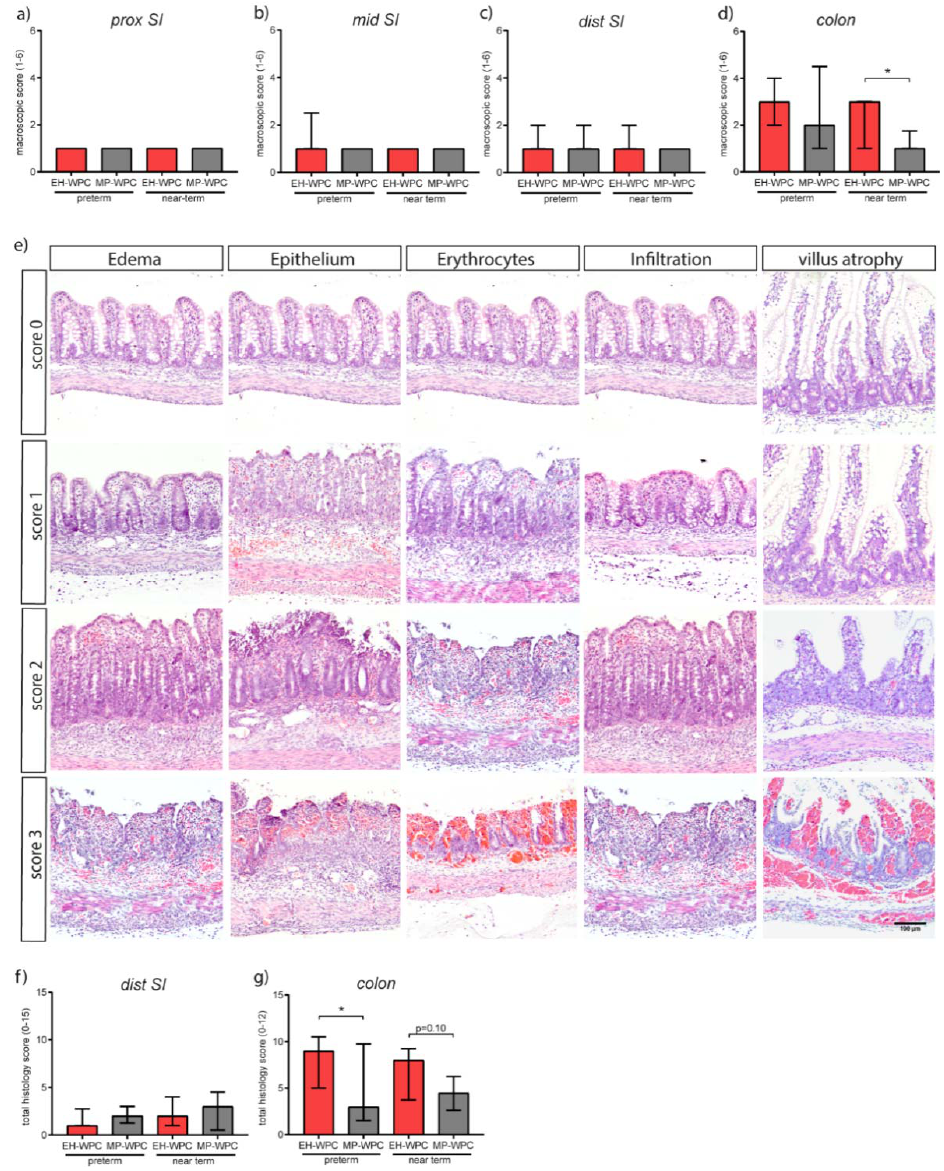
Figure 1. Mildly pasteurized whey protein concentrate (MP-WPC) limits colonic lesions. After 5 days of enteral nutrition, the gastro-intestinal tract of preterm and near-term piglets was macroscopically scored for signs of gastroenterocolitis in ( a ) proximal small intestine, ( b ) middle small intestine, ( c ) distal small intestine and ( d ) colon. ( e ) Representative images of various degrees of lesions observed, including edema, epithelial damage, presence of erythrocytes, infiltration of inflammatory cells and villus atrophy. Tissue was further evaluated microscopically with a total histology score for ( f ) distal small intestine and ( g ) colon. Values are median ± IQR, * p ≤ 0.05. Scalebar equals 100 μ m.